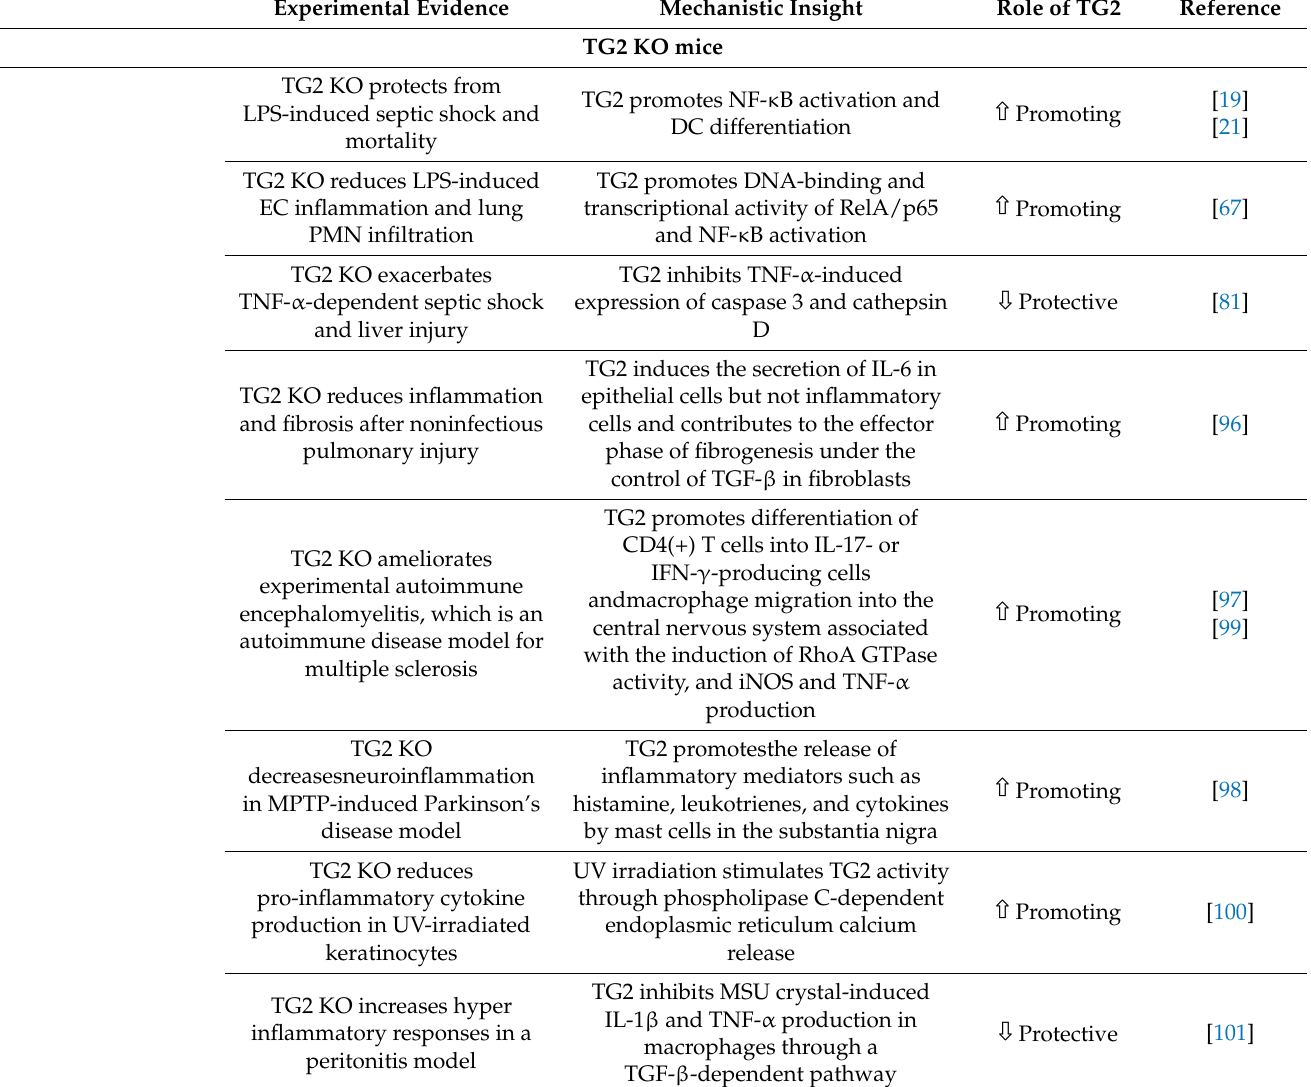
Table 1. Evidence for genetic and pharmacological inhibition of TG2 during inflammation and sepsis.